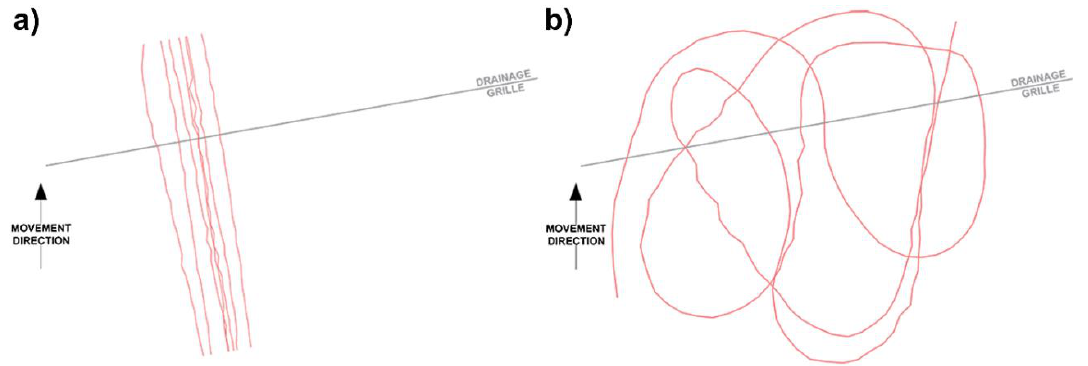
Figure 7. Implemented variants of GPR profiling: ( a ) parallel, ( b ) irregular.